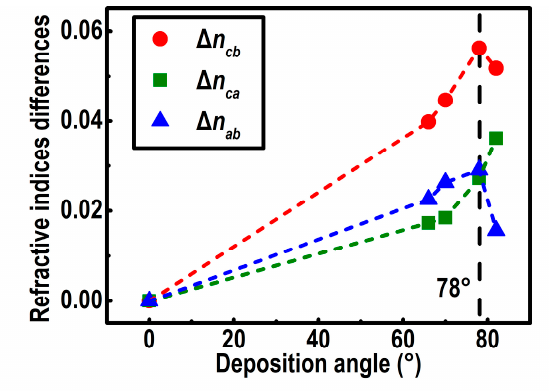
Figure 9. Refractive indices differences Δ n cb (red dots), Δ n ca (green squares), and Δ n ab (blue triangles) at 550 nm for YF 3 films versus deposition angle. Dashed lines are guides for the eye.